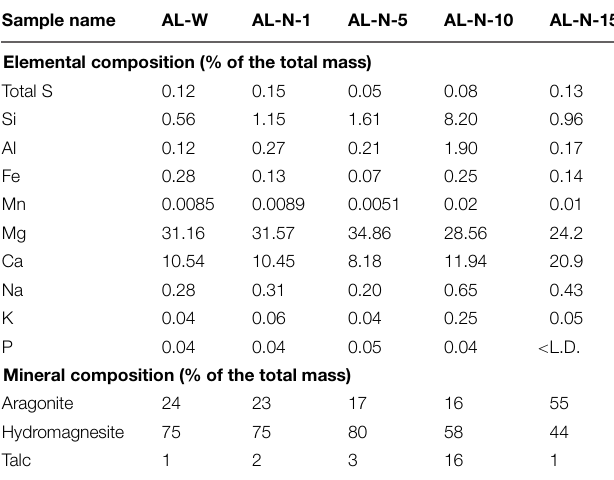
TABLE 1 | Proportion of major elements and minerals present in Alchichica microbialite